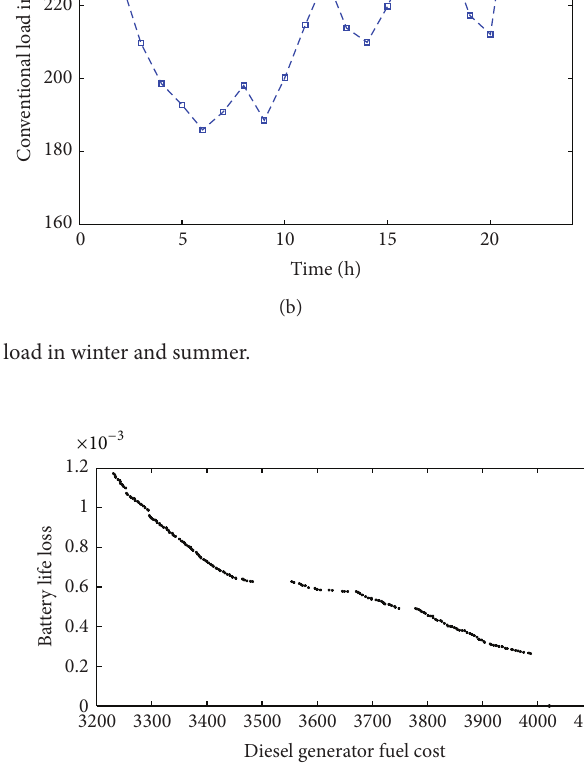
Figure 9: The result of Pareto front considering the effect of auxiliary power